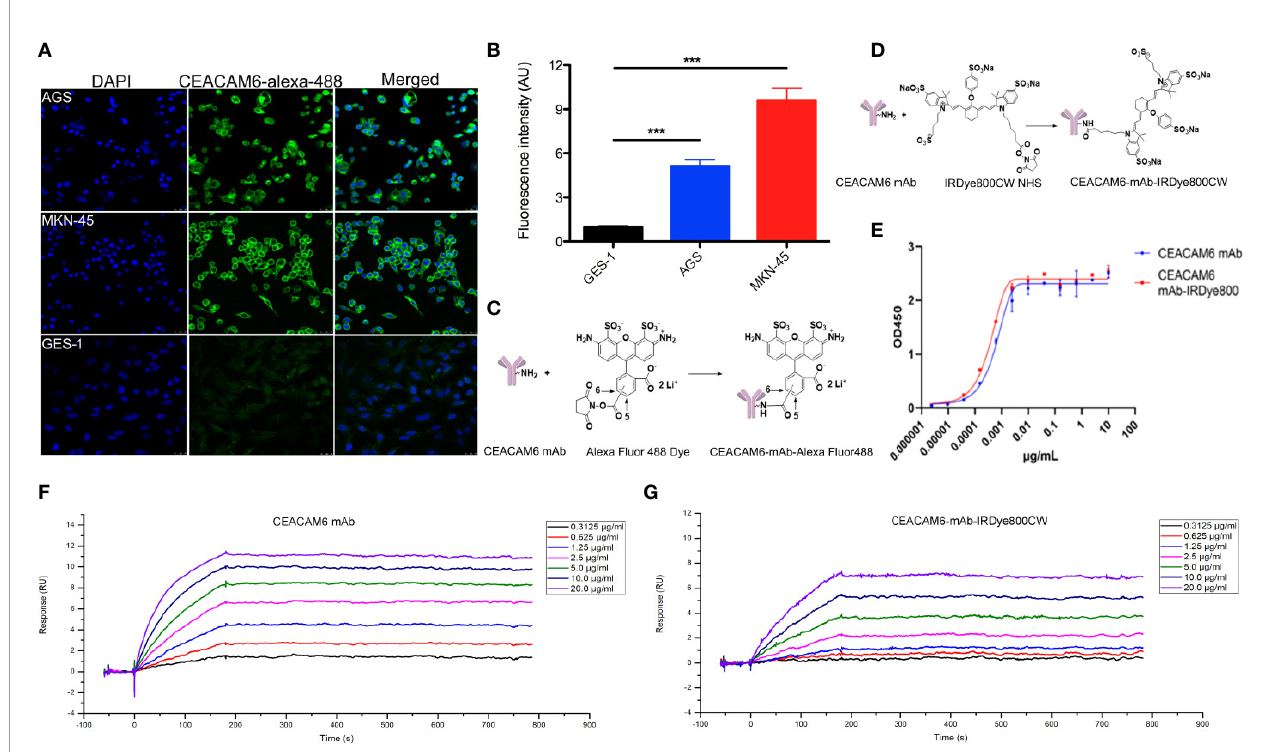
FIGURE 5 | The af fi nity of CEACAM6-mAb-Alexa Fluo488 probe to GC cells and the CEAACM6-mAb-IRDye800CW probe tracked the tumor in mice model. (A) The AGS, MKN-45 and GES-1 cells were cultured and incubated with CEACAM6-mAb-Alexa Fluo488 probe (1:20, green signal), the nucleus were stained with DAPI (blue signal), 10 randomly selected fi elds were checked under confocal microscope. (B) Quanti fi cation of the mean fl uorescence intensity in the cells by Image- Pro Plus software (fold change from GES-1), and the bar graph was drawn, data are expressed as the mean (± SEM) of values from three independent experiments. ***p < 0.001. (C) The chemicalmolecular modeldiagram of CEACAM6-mAb-Alexa Fluor488 was showed. (D) The chemicalmolecular model diagram of CEACAM6- mAb-IRDye800 was showed. (E) The activity of CEAACM6-mAb-IRDye800CW was evaluated by ELISA method, the optical intensity was measured by spectrophotometer (OD450nm). The Y-axis respresented the OD value, the X-axis represented the different concentration of antibody, the fi tting curve was generated based on the OD value and the IC50 was calculated according to the fi tting curve by GraphPad Prism 8.0.2. (F, G) The surface plasmon resonance (SPR) analysis was used to test af fi nity of CEACAM6 mAb and CEACAM6 mAb-IRDye800CW to CEACAM6 respectively, Y-axis respresented the fl uorescence signal value, the X-axis represented the times, the different diluted concentration of antibody were showed in the different